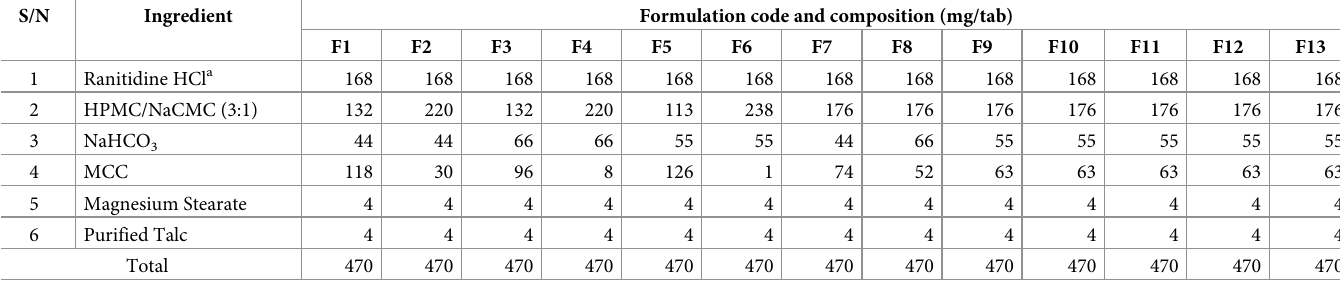
Table 2. Composition of floating, bioadhesive and swellable matrix tablets of ranitidine HCl (150 mg) prepared by CCD. S/N